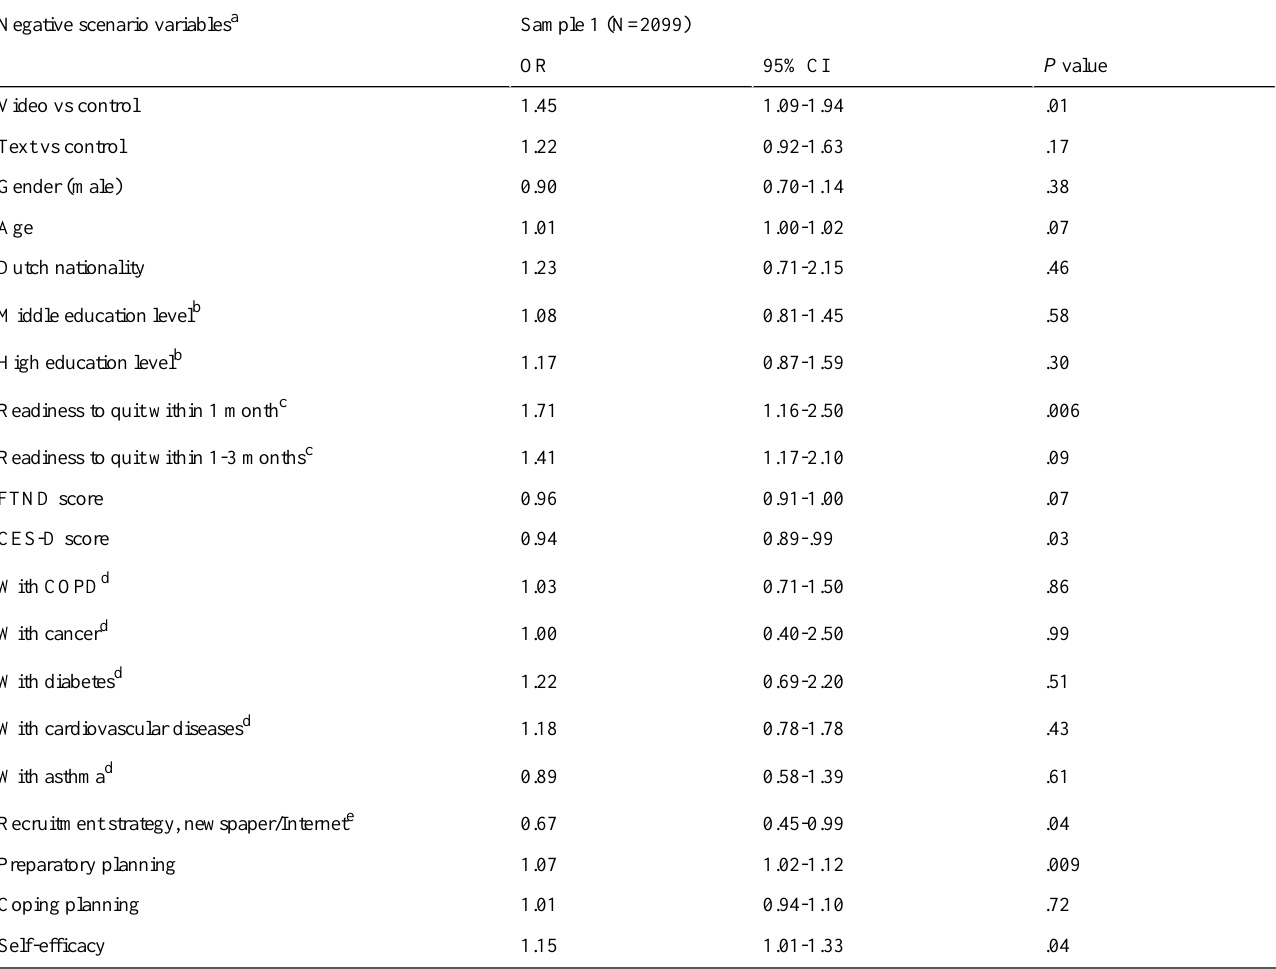
Table 3. Factors associated with 7-day point prevalence abstinence in sample 1 (negative scenario) in the present